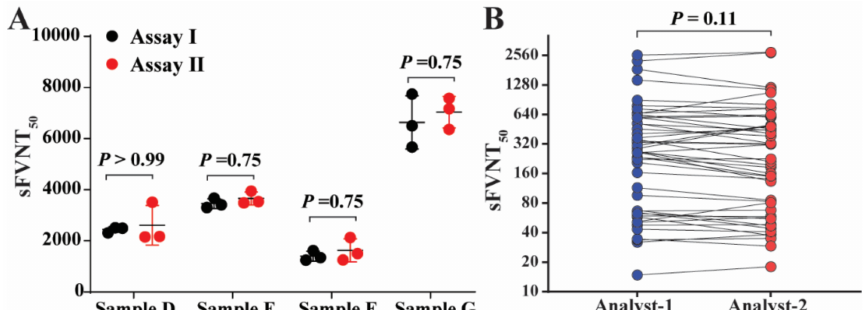
Figure 5. Reproducibility of the SFVNT. ( A ) Intra-reproducibility. The SFVNT was performed twice on different days using four neutralization-positive and four neutralization-negative samples tested in a duplication manner in three different plates. The mean and standard deviations from both repeats are shown (neutralization-negative samples are not shown). p values from the Wilcoxon matched-pairs signed-rank test are shown. ( B ) Inter-reproducibility. Ten negative and 48 positive serum/plasma samples were tested using the SFVNT by two different analysts. The SFVNT50 values for each neutralization-positive sample were compared. The p value from the Wilcoxon matched-pairs signed-rank test is